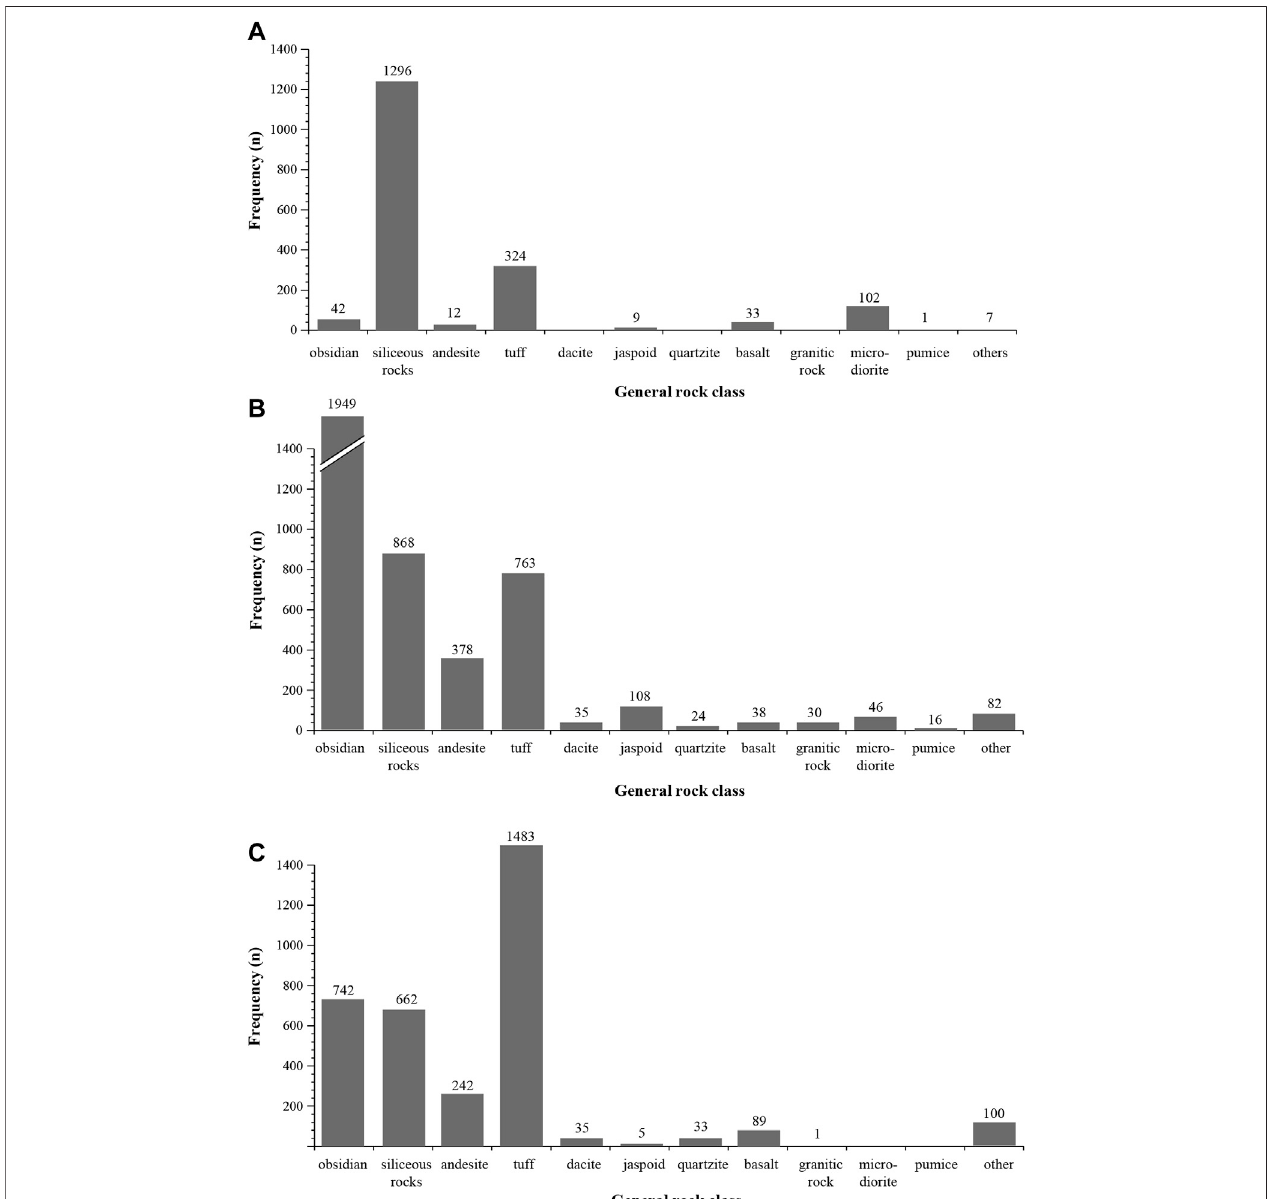
FIGURE 3 | Frequency of archaeological artifacts by rock class: (A) Tuina-5 (IV); (B) Tambillo-1; (C) Tulán-67(VII).